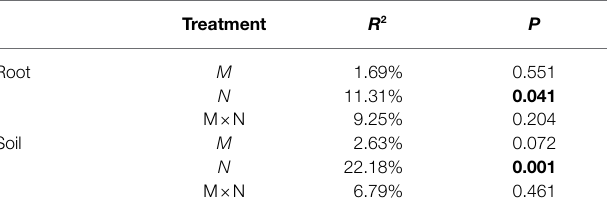
TABLE 2 | Results from a permutational multivariate analysis of variance (PERMANOVA) testing the effects of nitrogen addition, mowing, and the interaction on Bray–Curtis dissimilarity of AM fungal community in soil and roots,